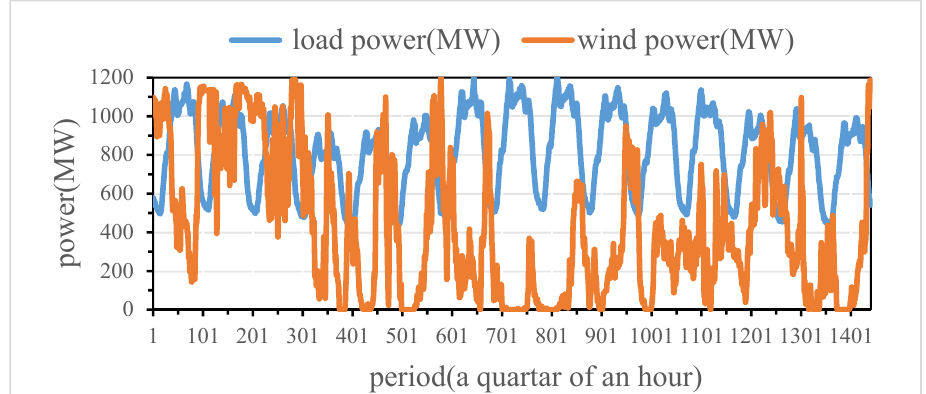
Figure 3. Power load and wind power output.